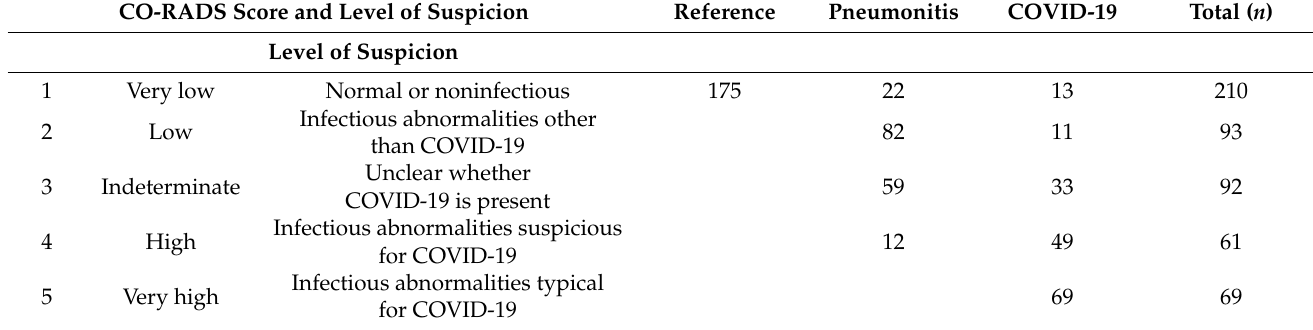
Table 2. Number of lobe-wise CO-RADS scores for all patients.